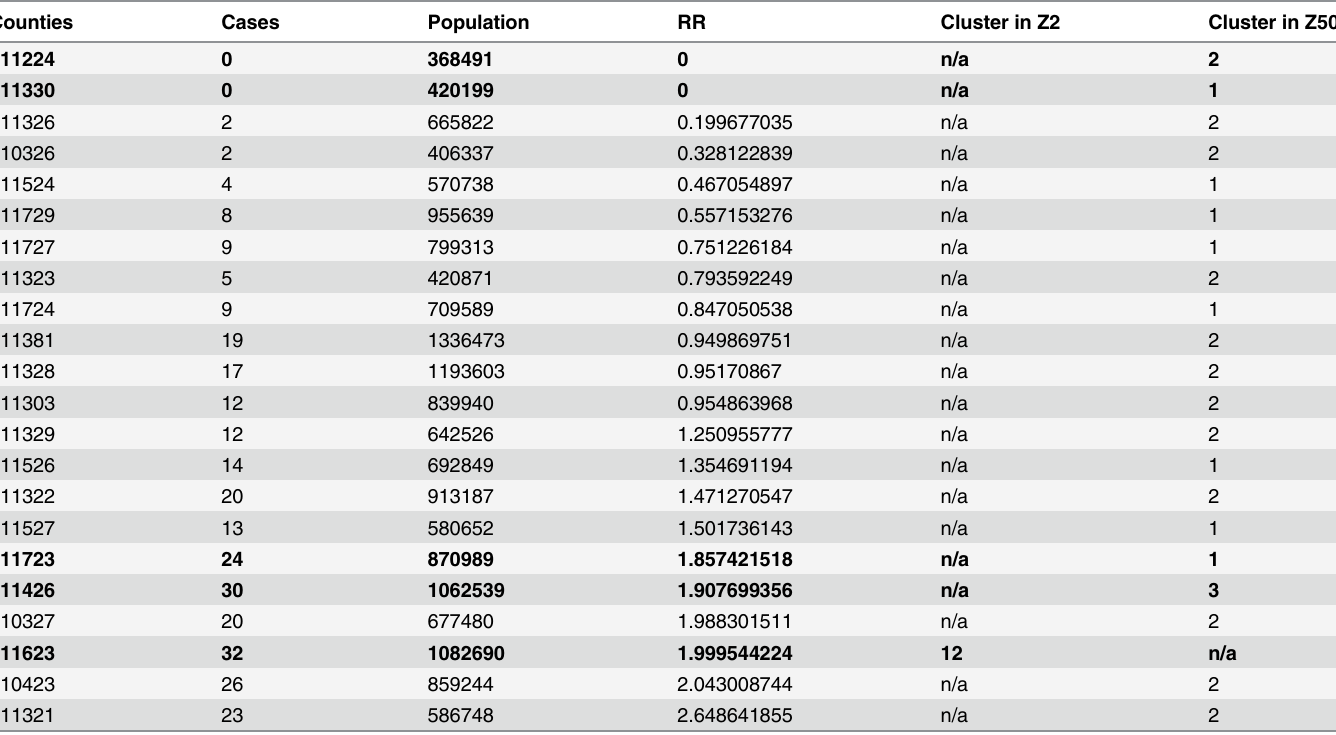
Counties in boldface are mentioned as